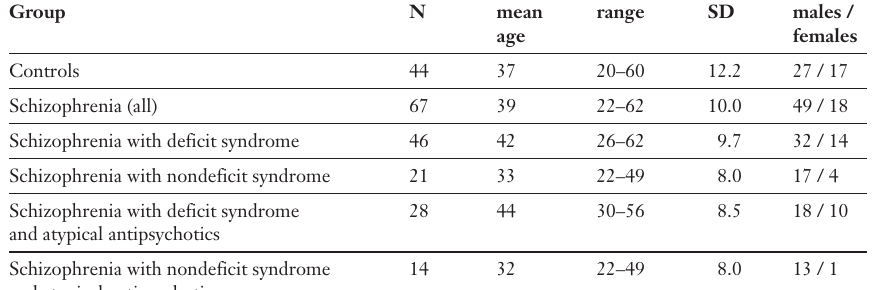
Demographic data.